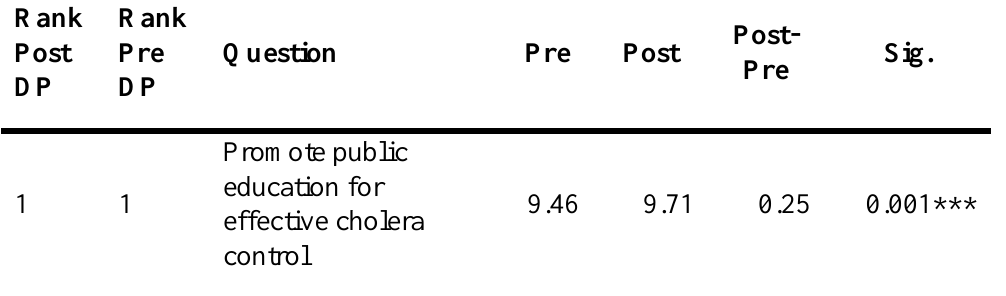
Table 1: All Proposals After Deliberation with Ranking Post and Pre Tamale Deliberative Poll – Pre and Post